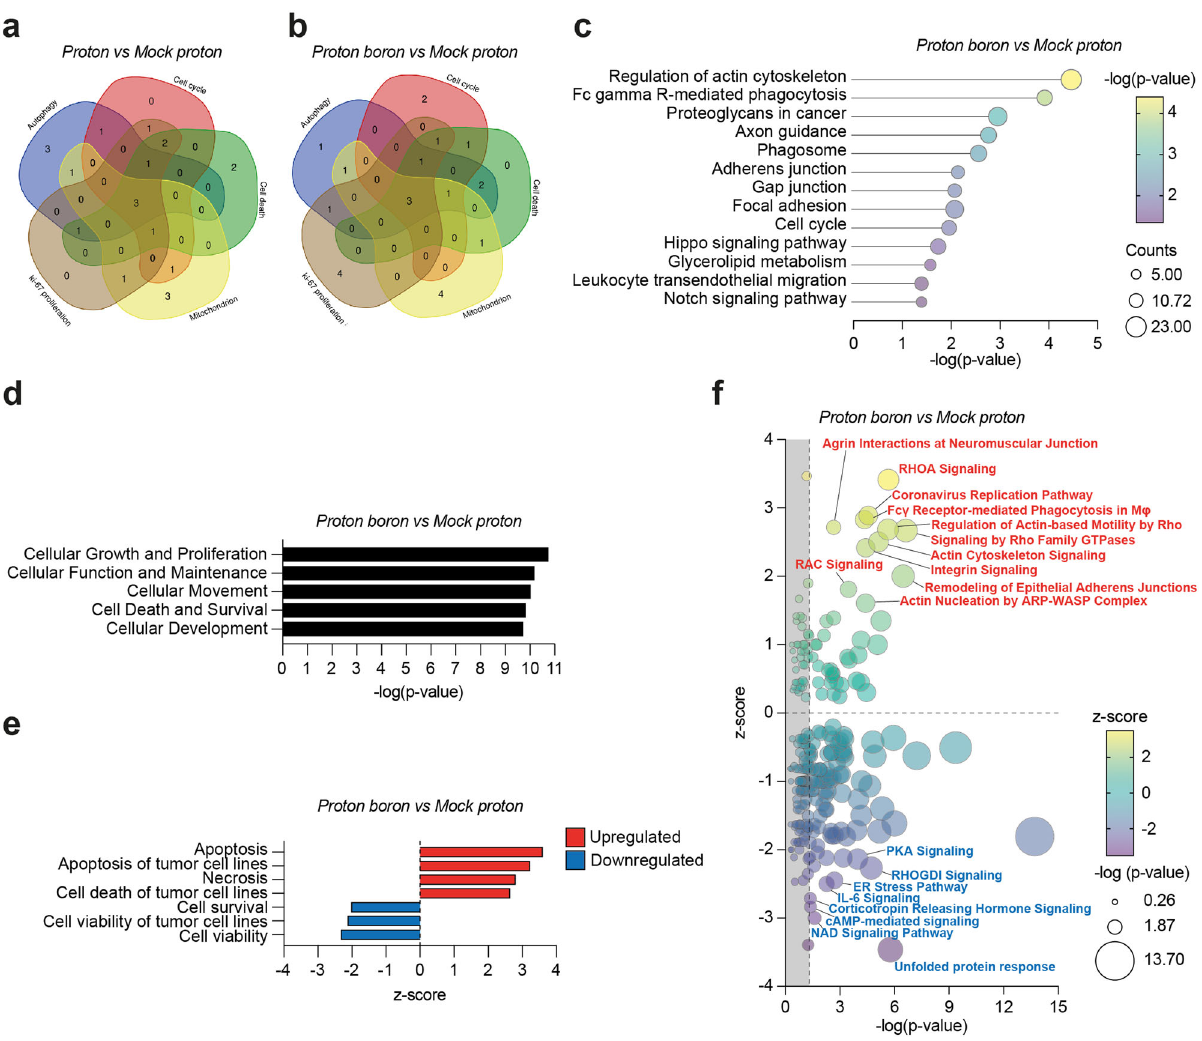
Fig. 4 PBCT induces cell death upregulation and cell viability downregulation pathways in association with cytoskeleton remodeling and cellular communication. a , b Functional enrichments analysis of differentially expressed genes with Venn diagrams of gene expression pro fi les in proton vs mock proton and in proton boron vs mock proton. c Speci fi c biological pathways analysis by DAVID software of upregulated transcripts in which dots are key colored according to their – log( p -value) and their dimensions are proportioned to counts number. d , e Speci fi c statistically signi fi cant pathways analysis by IPA software and detailed IPA analysis of death/survival balance. f Data enrichment analysis with most statistically and biologically relevant pathway in GBM tumor sample derived from mock proton versus proton boron treated mice in which dots are key colored according to their z-score and their dimensions are proportioned to their – log( p